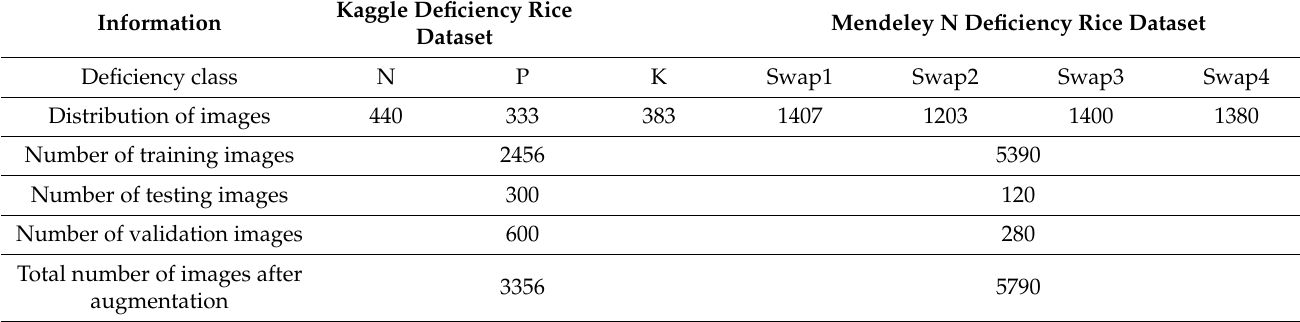
Table 3. Details of the rice deficiency datasets used in the current study.